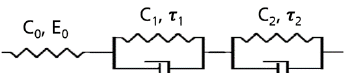
ficients ( C j : and τ j ) (Equation (2)) and at infinite long time the relaxed elastic modulus ( E ∞ ) is described using only the elastic coefficient ( C 0 ) (Equation (3)) [29,36,38]. The creep ration ( CR ) (Equation (4)) measures the extent of viscoelasticity, describing how much is the material